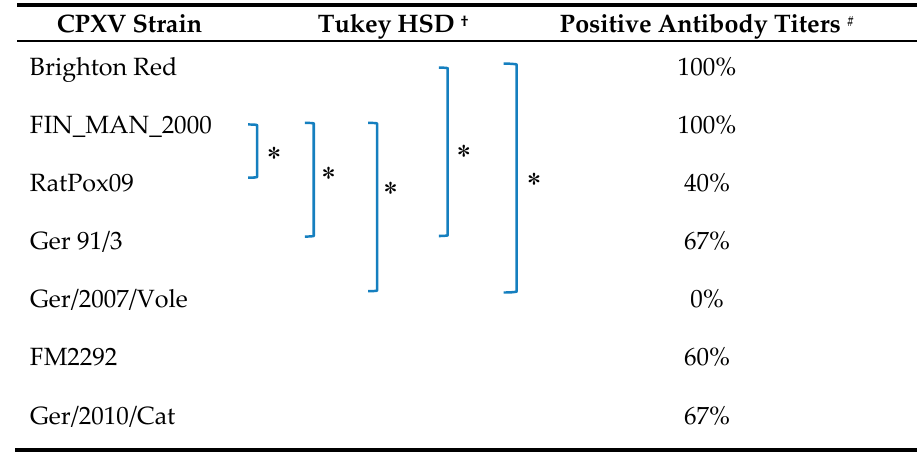
Table 3. Seroconversion rate of CPXV-inoculated bank voles at 21 dpi.